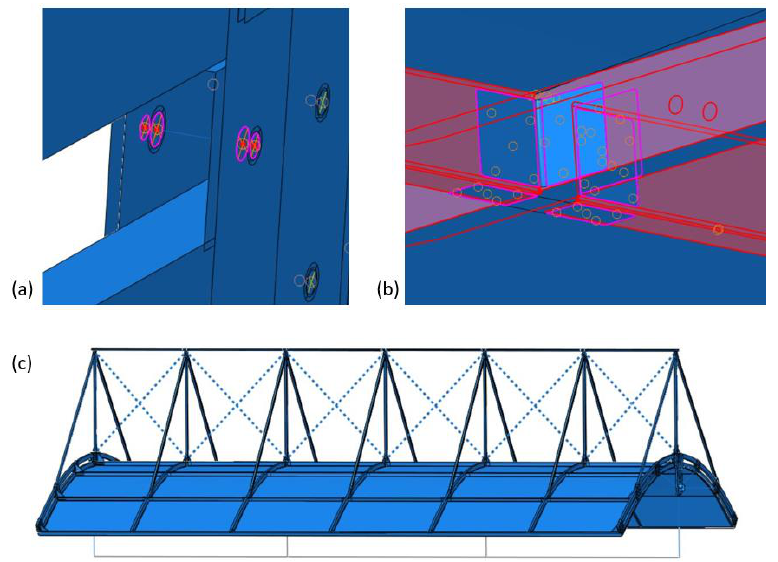
Figure 5. ( a ) Coupling pairing, ( b ) tie constraint between adhesive layer and the joint, ( c ) connectors reproducing the back-crossing tie rods.